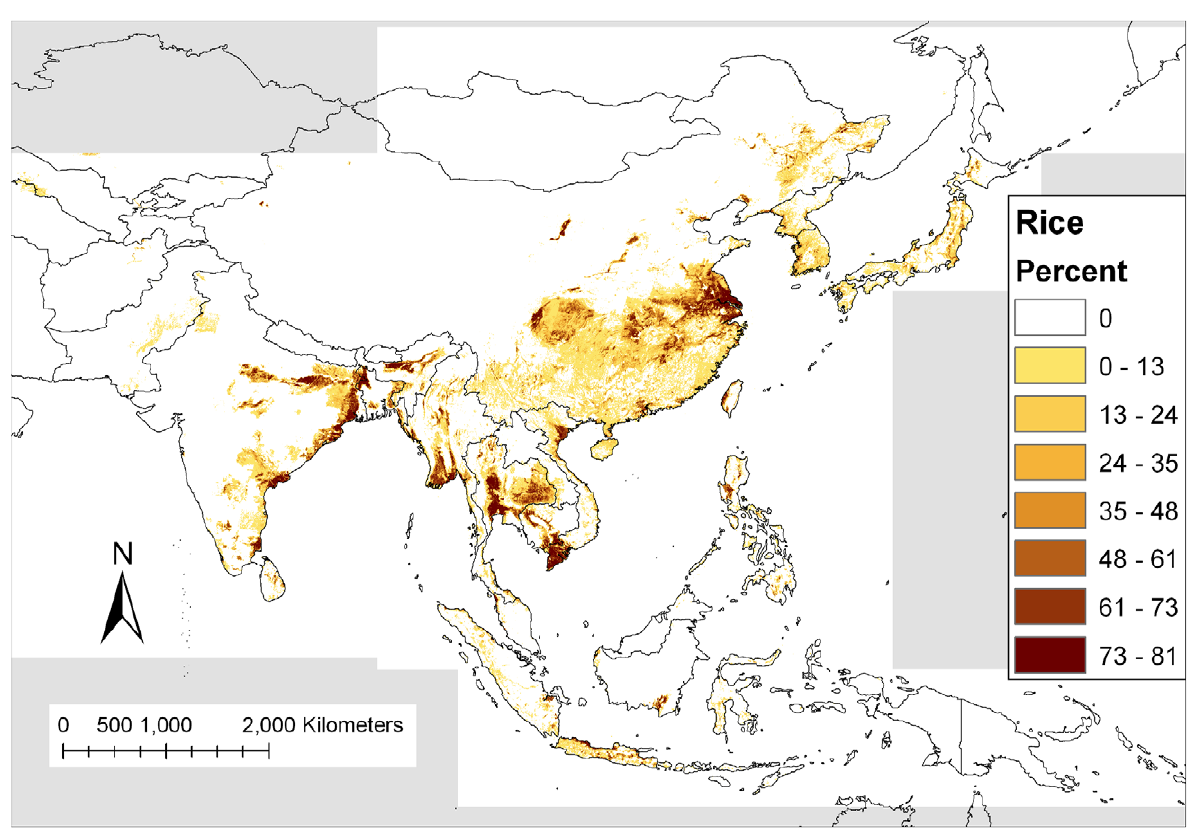
Figure 5. Percent of 30 meter pixels classified as rice land cover within 1 one square kilometer derived from the GeoCover Land Cover product. Gray areas indicate no